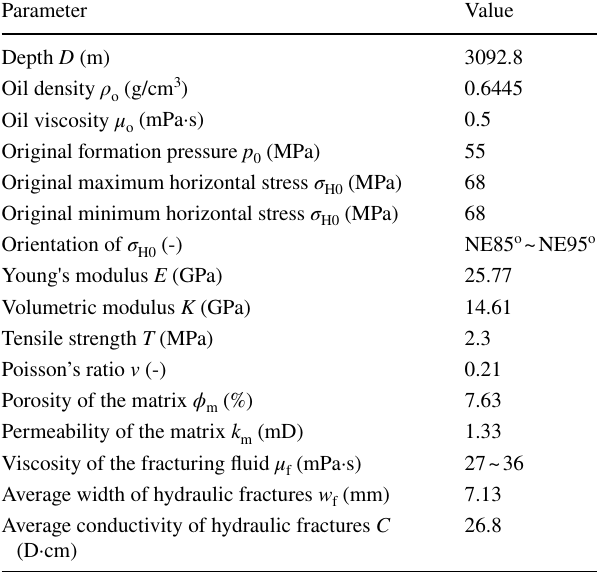
Table 2 Geological and engineering characteristics of the formation Parameter